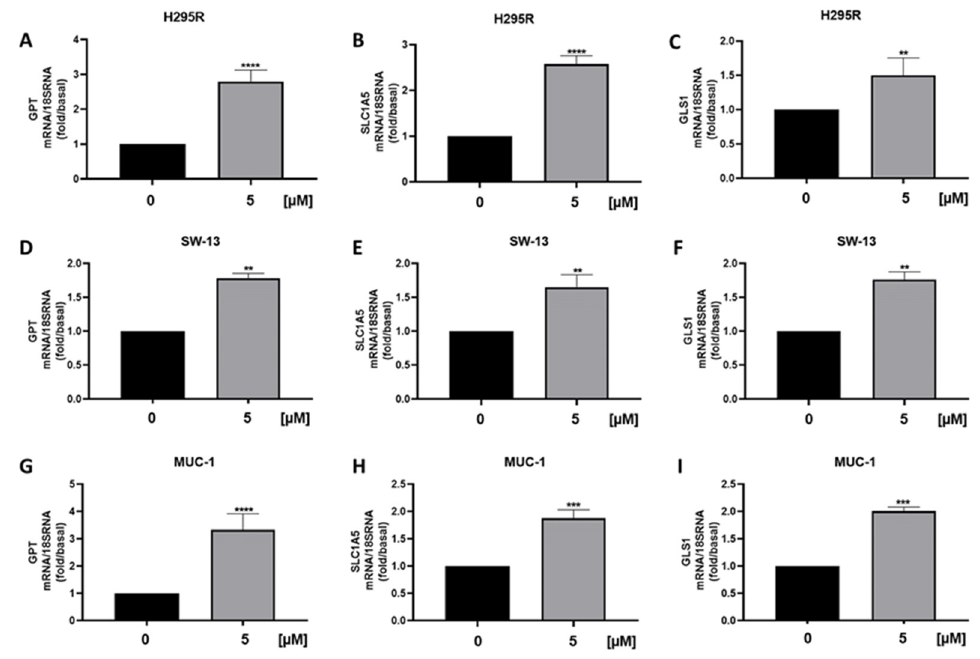
Figure 10. Effects of ERR α depletion on glutamine metabolism in ACC cell lines. Real ‐ time RT ‐ PCR for GPT, SLC1A5, GLS1 gene expression in H295R cells ( A – C ), SW ‐ 13 cell ( D – F ) and MUC ‐ 1 cells ( G – I ) treated with XCT790 (5 μ M) for 24 h. Data represent the mean ± SE of values from at least three independent RNA samples (** p < 0.01; *** p < 0.001; **** p < 0.0001 vs. 0 μ M).